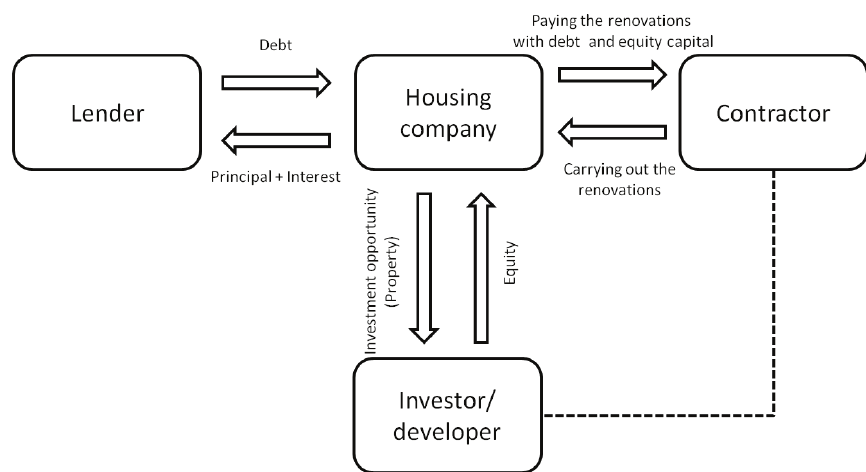
figure 2. Debt and equity financing (after luoma-Halkola et al . ,